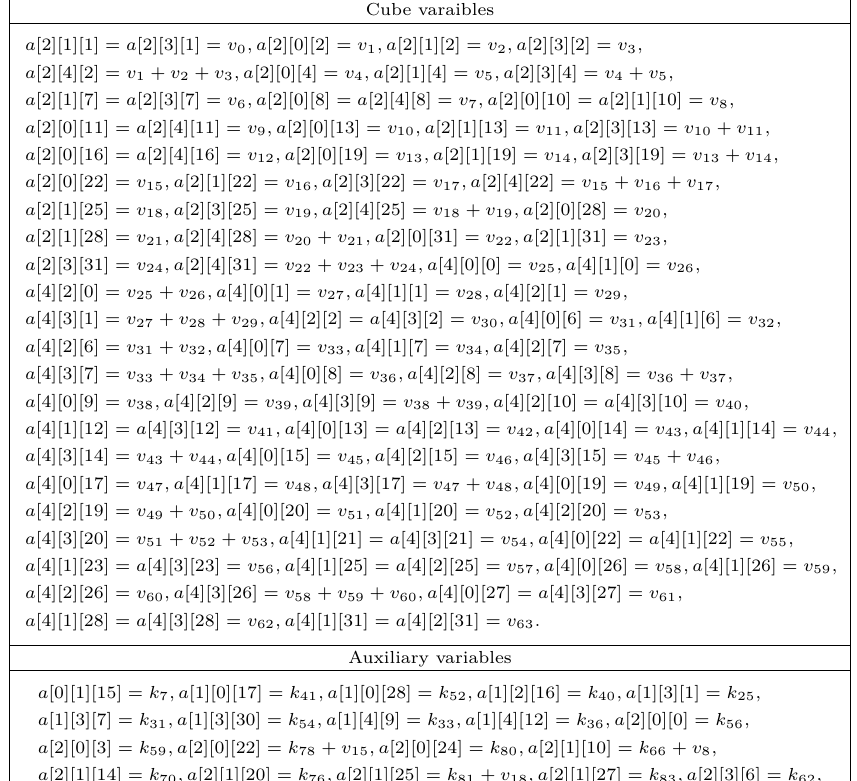
Table 17: A 64-dimensional cube for Ketje Minor, where ( n a , n i ) = (27 , 27). In total, there are 52 bits key information involved in both auxiliary variables and involved key